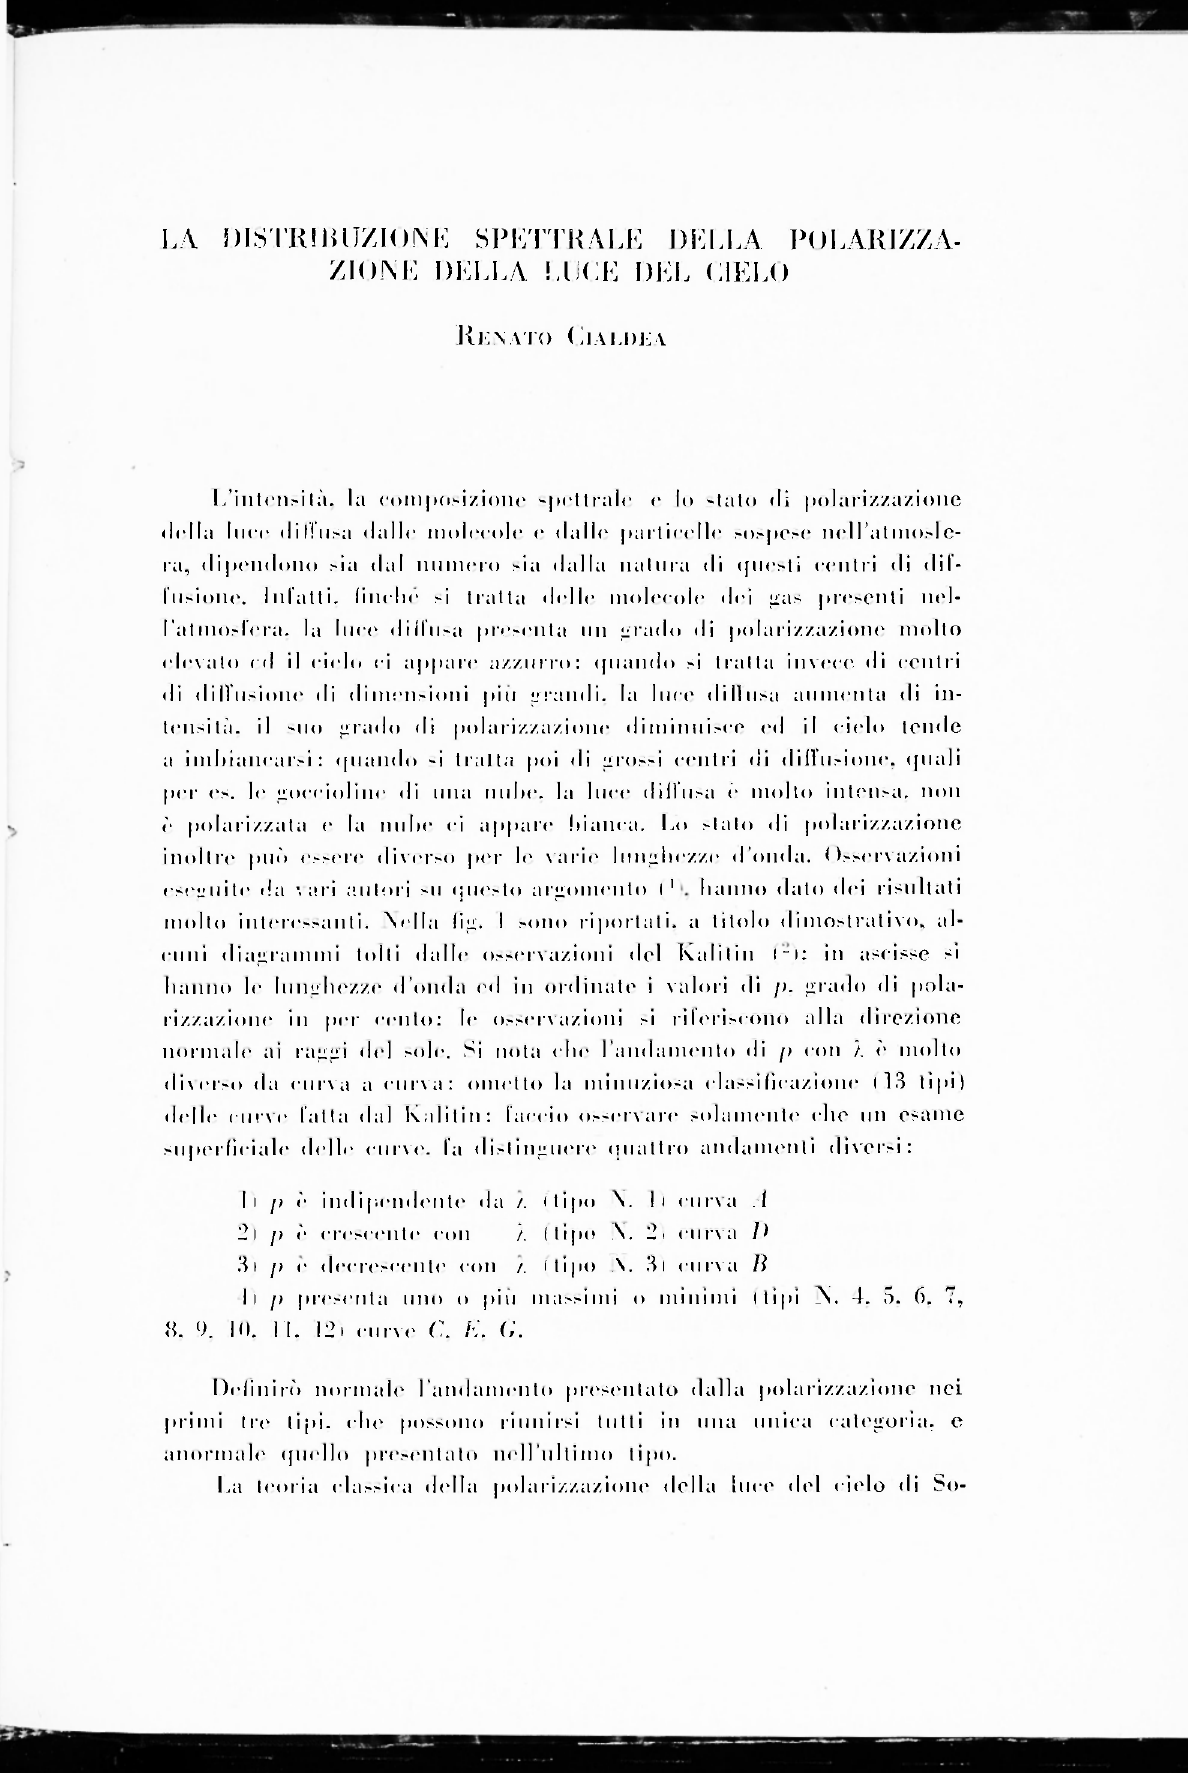
delle curve fatta dal Kalitin: faccio osservare solamente clic un